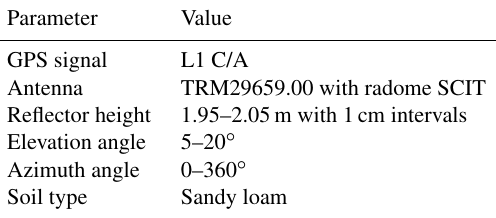
Table 1. Key parameters for SNR